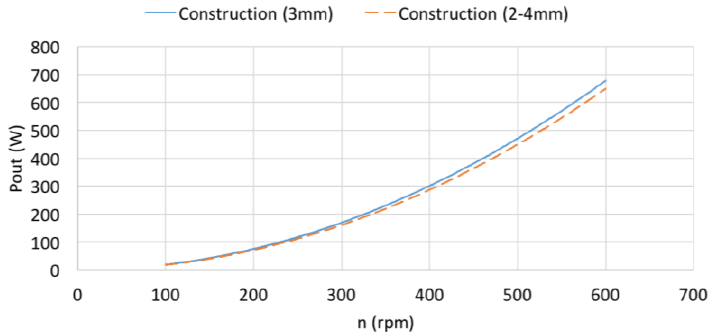
Figure 21. Plot versus the speed of the output power in constructed model with 3 mm air gaps compared to that of the constructed model with 2–4 mm air gaps.